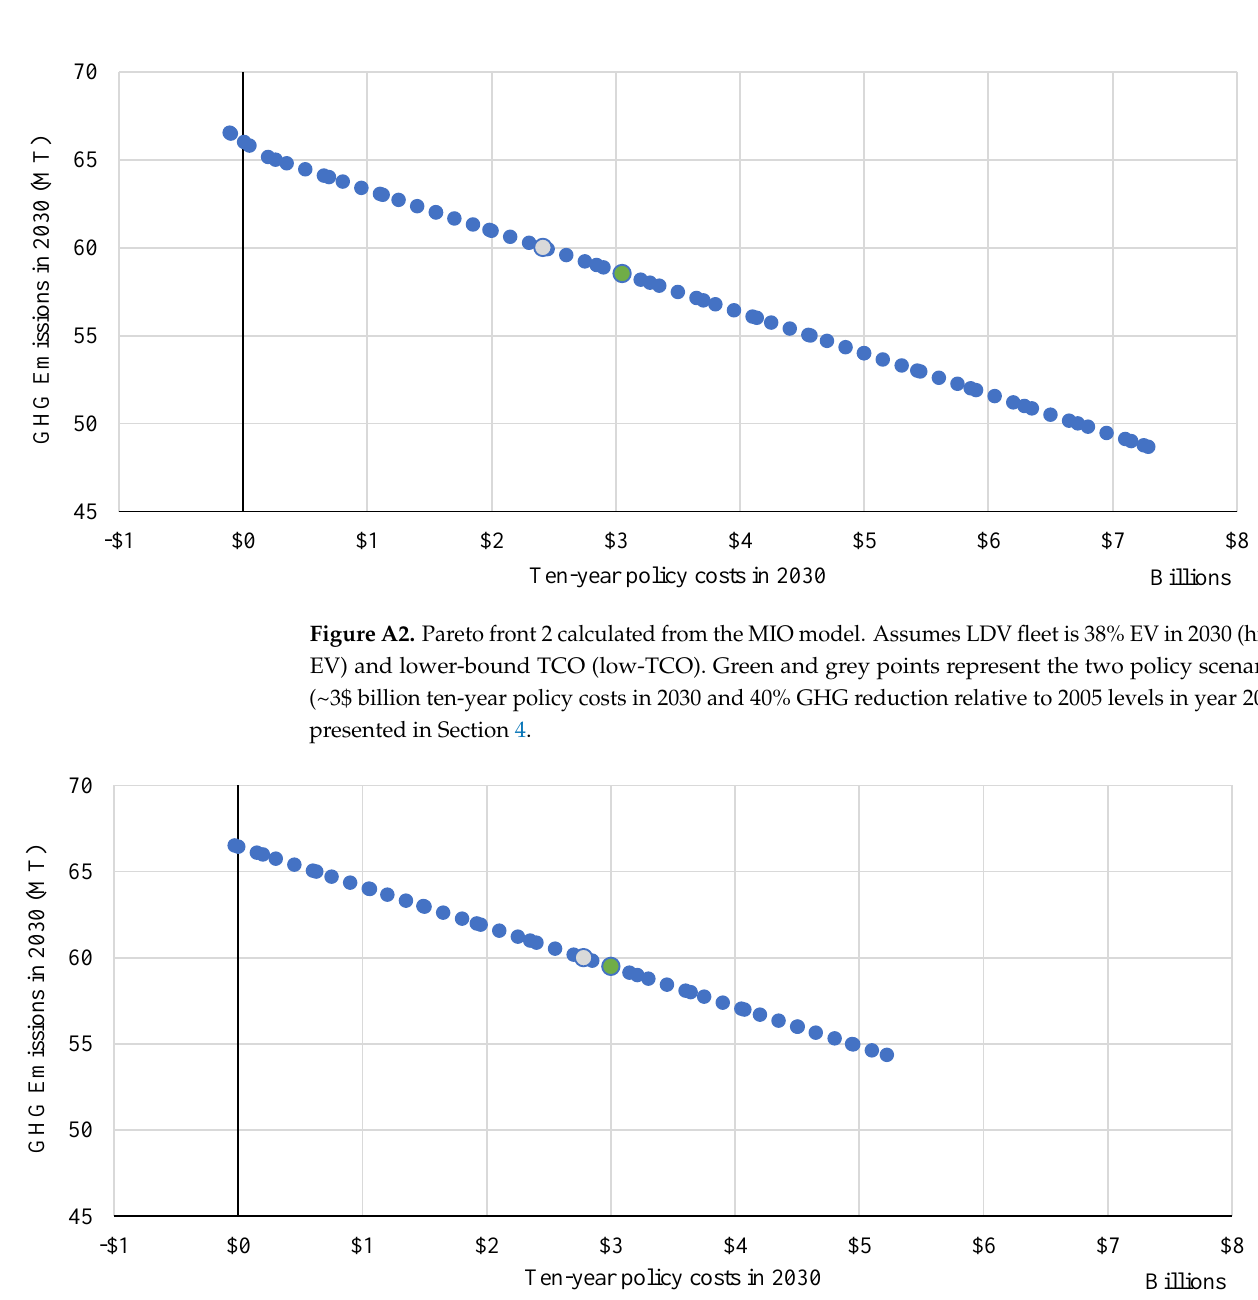
Figure A1. Pareto front 1 calculated from the MIO model. Assumes LDV fleet is 38% EV in 2030 (high-EV) and upper-bound TCO (high-TCO). Green and grey points represent the two policy sce- narios (~3$ billion ten-year policy costs in 2030 and 40% GHG reduction relative to 2005 levels in year 2030) presented in Section 4.